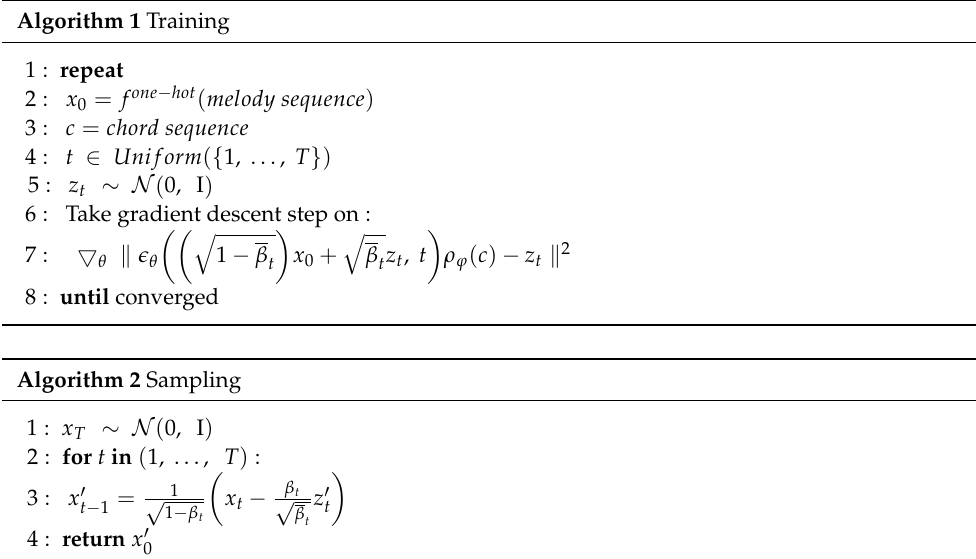
Figure 4. Pipeline of the conditioned-denoising in reverse process. Algorithm 1 shows the training of MelodyDiffusion, while Algorithm 2 shows the method of sampling new melodies using Gaussian noise and conditional chords after the model has